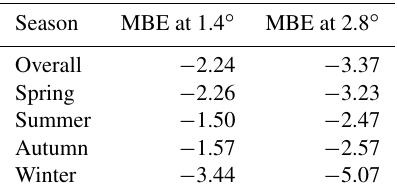
Table 8. Comparison of the seasonal mean NO 2 profiles (0–2km) among MAX-DOAS and CHASER simulations at 2.8 and 1.4 ◦ res- olutions at Chiba. MBE (CHASER − MAX-DOAS) at 1.4 and 2.8 ◦ is the mean bias error at the respective resolutions. The MBE unit is parts per billion by volume (ppbv). Season MBE at 1.4 ◦ MBE at 2.8